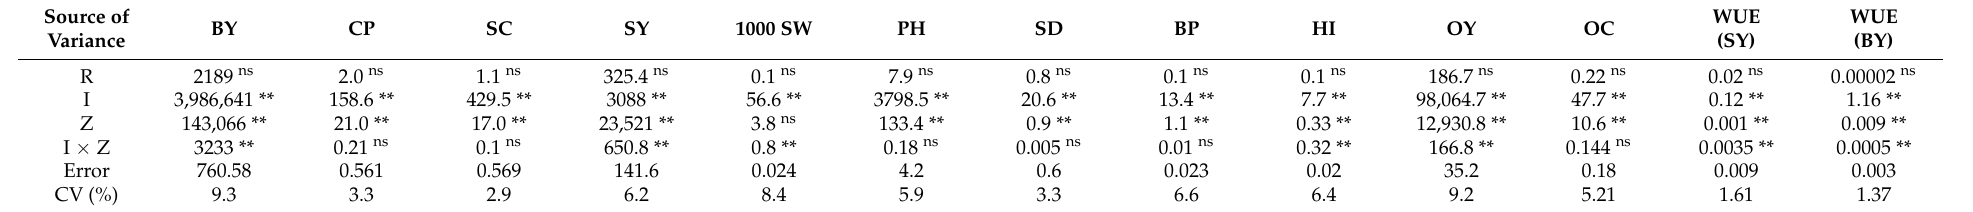
Table 6. ANOVA (mean squares) for measured traits influenced by foliar application of ZnO (second year). Source of